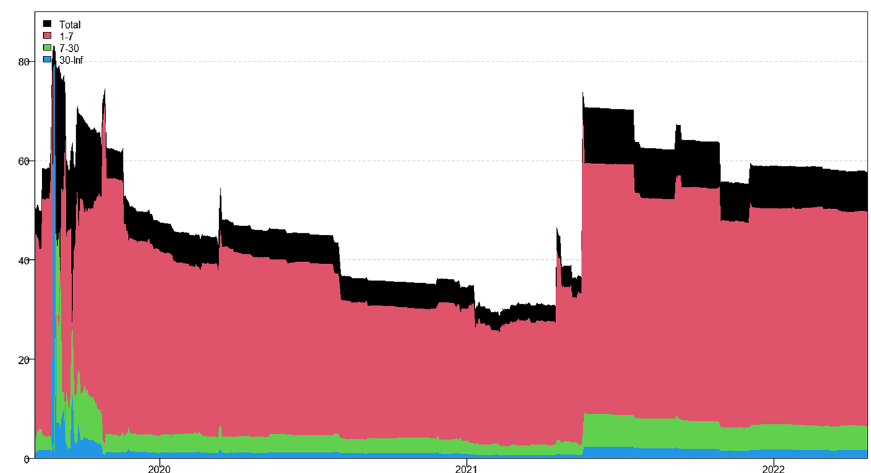
Fig. 11 Dynamic total connectedness—signed jump variation